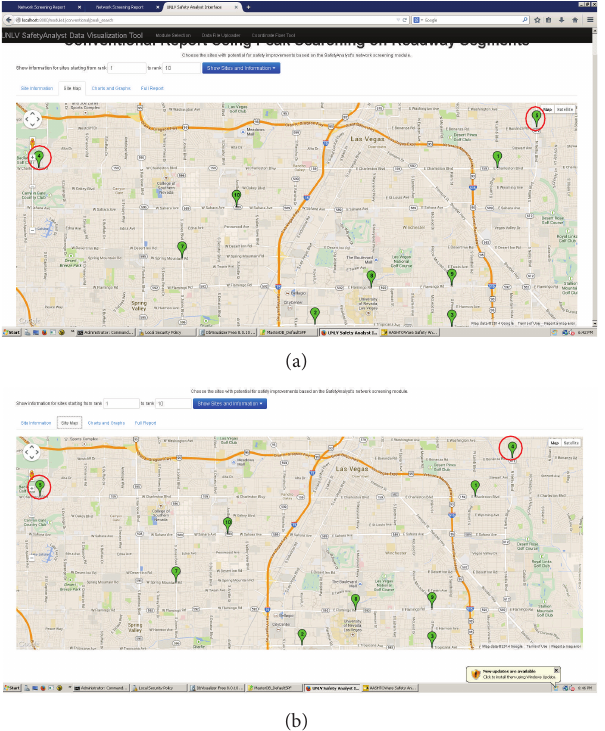
Figure 5: (a) Results of a basic network screening for fatal and all injury crashes at intersections, using default SPF, and (b) results of basic network screening for fatal and all injury crashes at intersections, using calibrated